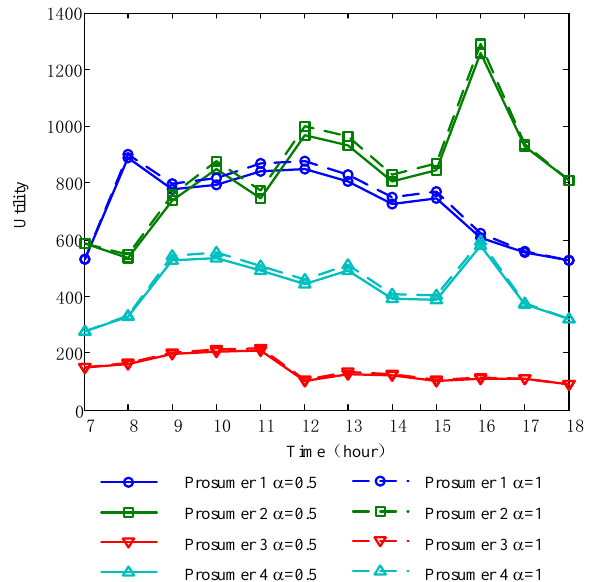
Figure 14. Impact of α on prosumers’ utility.